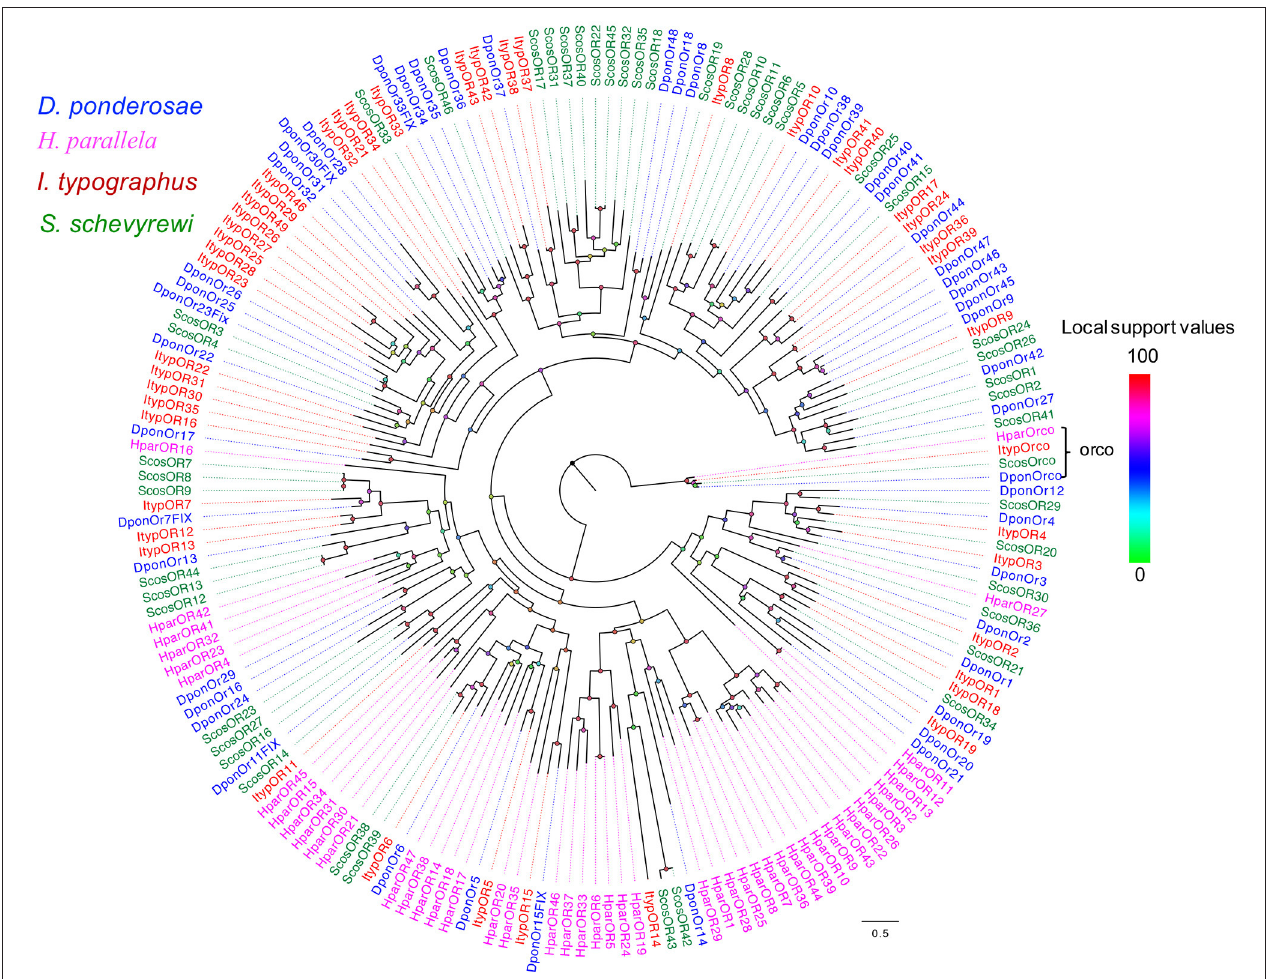
FIGURE 1 | Phylogenetic tree of candidate ScosORs with known Coleoptera odorant receptors sequences. Dpon, D. ponderosae ; Hpar, H. parallela ; Ityp, I. typographus ; Scos, S. schevyrewi